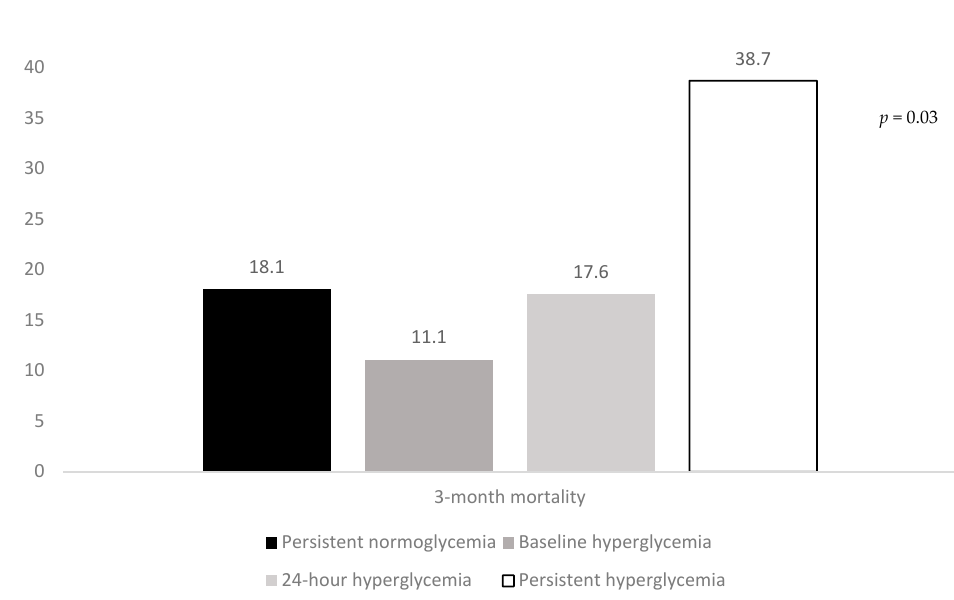
Figure 2. Rates of three-month mortality according to the hyperglycemic patterns.